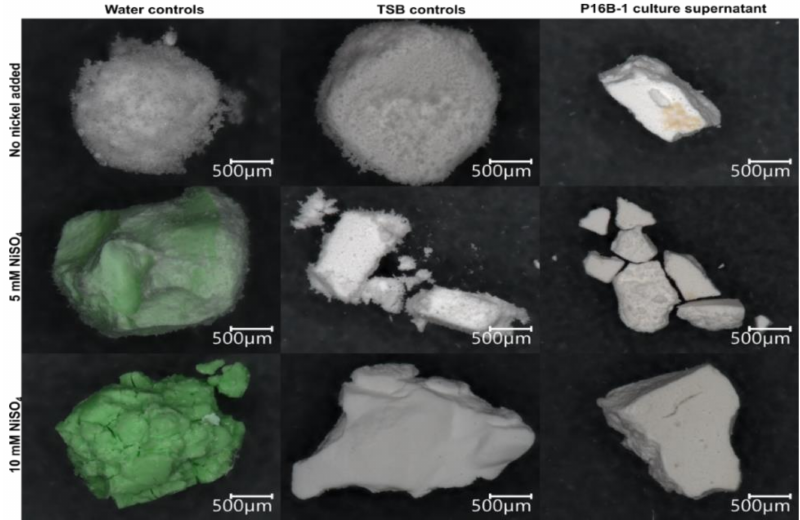
Figure 5. Biomimetically synthesized struvite crystals. Water and TSB medium